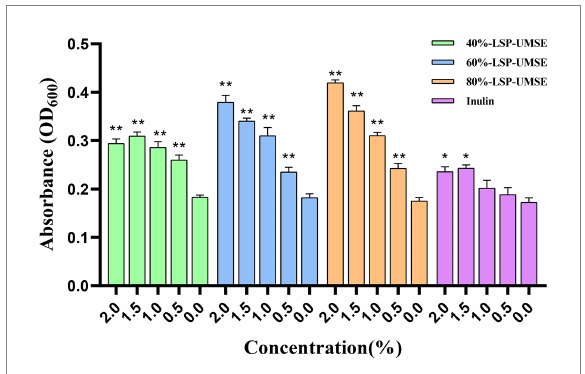
FIGURE 8 Optimal concentration for 24 h incubation (Note: 0% was used as control, * was significantly p < 0.05, ** was extremely significantly p <